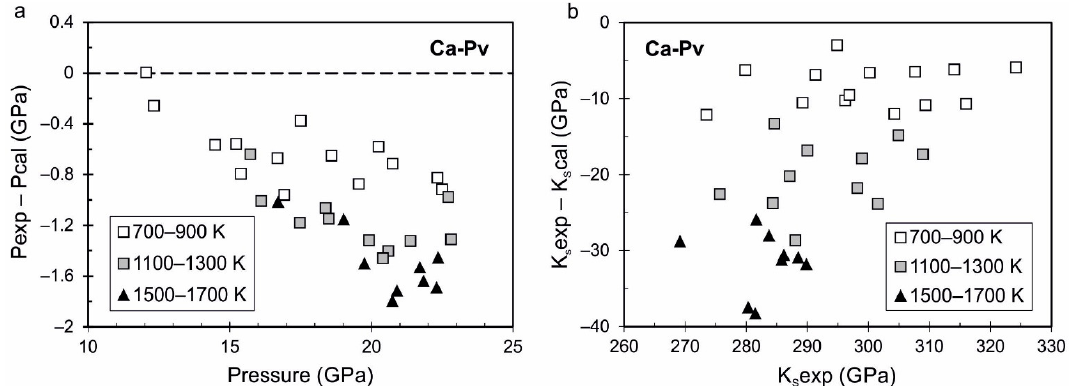
Figure 5. Difference between experimental measured pressure ( a ) and adiabatic bulk modulus ( b ) from [64] and calculated pressure and adiabatic bulk modulus from the proposed equation of state of Ca-perovskite. The pressure in [64] is calculated from the equation of state of NaCl [67].